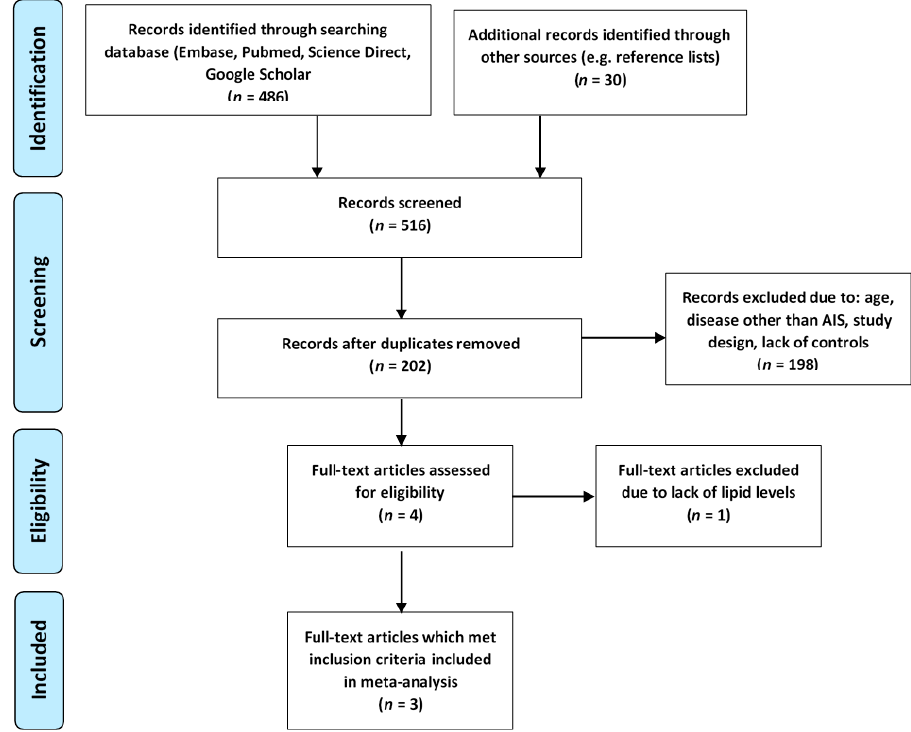
Figure 3. Flow chart presenting the process of searching for the eligible articles according to PRISMA guidelines.